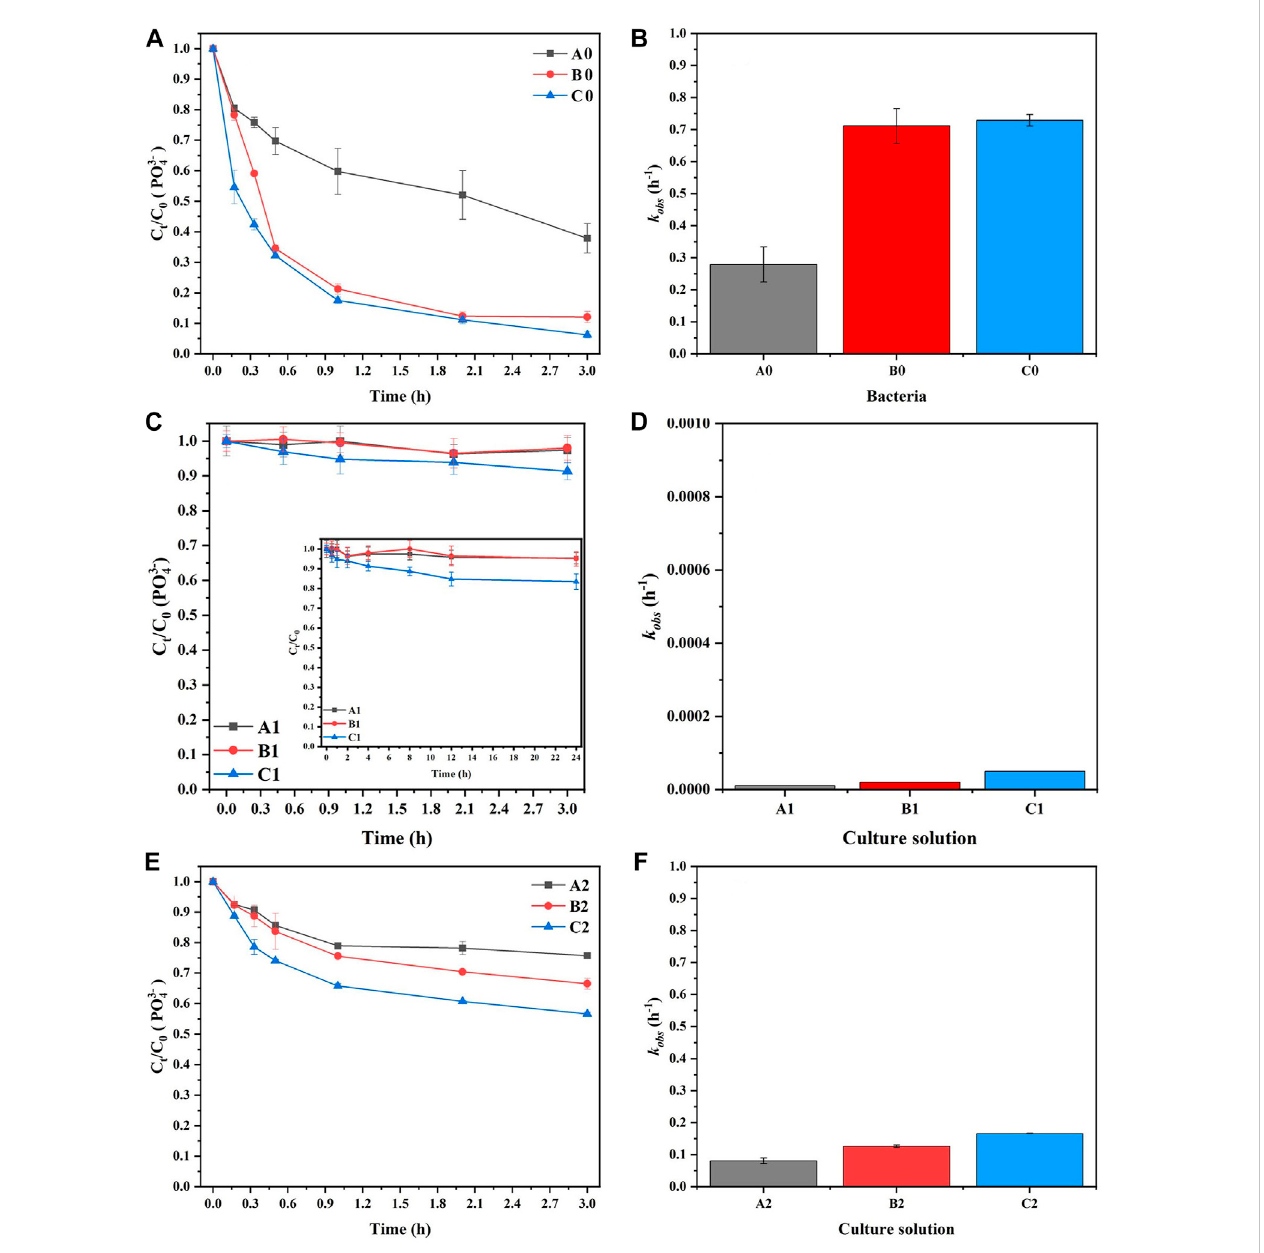
Theeffectofbacterialconcentrationon (A) theeliminationofPO 3 − 4 and (B) thecorresponding k obs value,theeffectofbacteriacellmembraneon (C) The elimination of PO 3 − 4 and (D) the corresponding k obs values, and the effect of sterile culture medium concentration on (E) the elimination of PO 3 − 4 and (F) the corresponding k obs value with